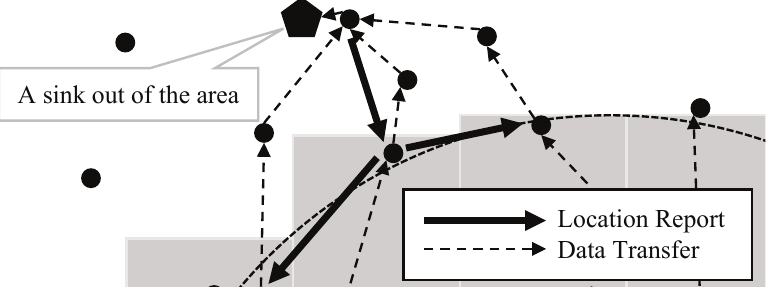
Figure 5. Mobility support for sinks out of the